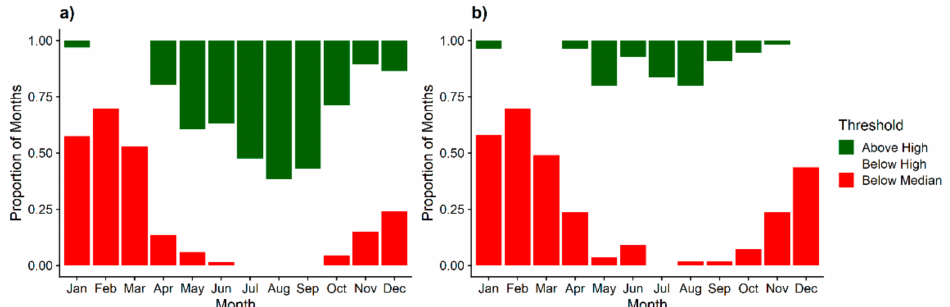
Figure 5. Frequency of months across the historical river flow record for the ( a ) Franklin River and ( b ) Davey River, during which the months were below the median flow threshold (red) and above the high flow threshold (green).